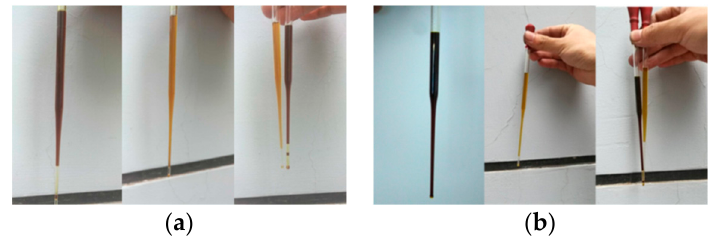
Figure 2. Oil appearance contrast chart. ( a ) In Experiment I, heavy oil, light oil, and their comparison chart; ( b ) In Experiment II, heavy oil, light oil, and their comparison chart.